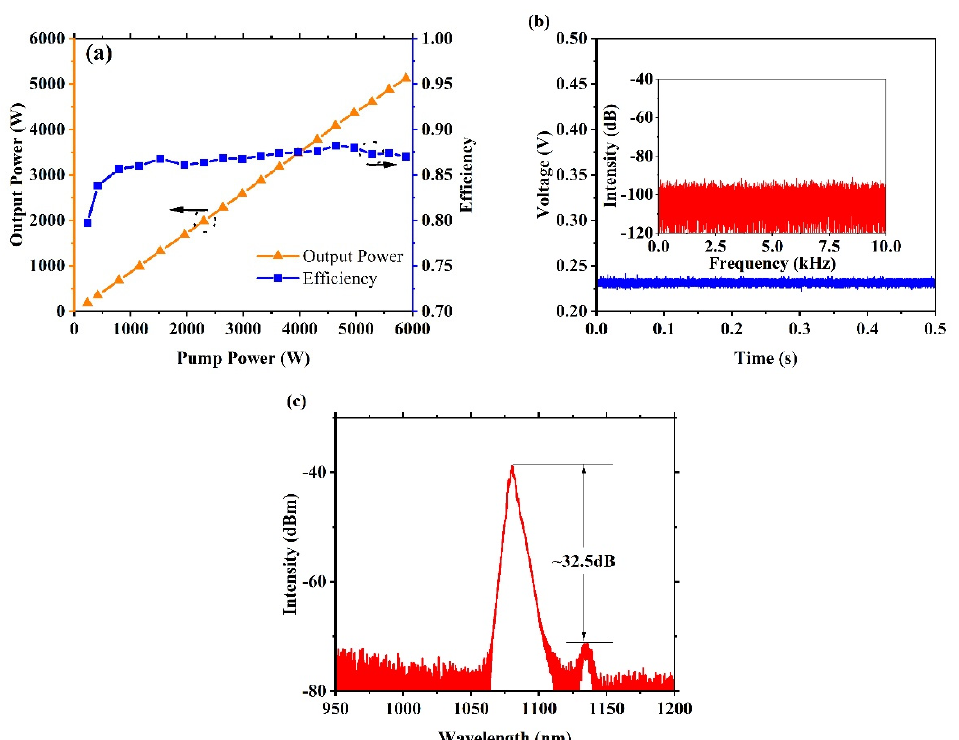
Figure 3. Output performance of the 981 nm pumped oscillator. ( a ) Output power and optical-to- optical efficiency. ( b ) Temporal trace and corresponding Fourier spectra (inset) at 5120 W. ( c ) Output spectrum at 5120 W.